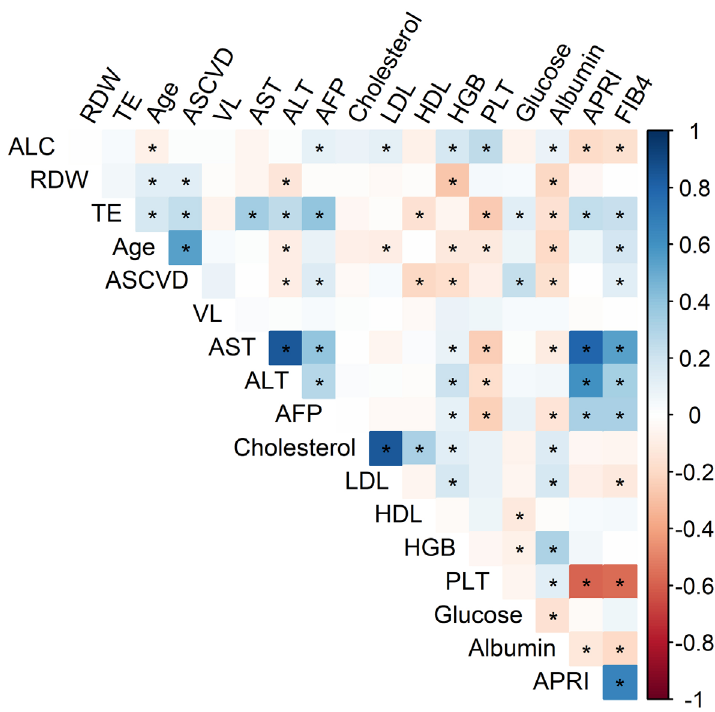
Figure 1. RDW, ALC, and TE score are associated with overlapping parameters, including those associated with CVD. Grid showing correlations between clinical parameters at time of TE, where r values are represented by color and P values <0.01 indicated by * for Spearman rank sum